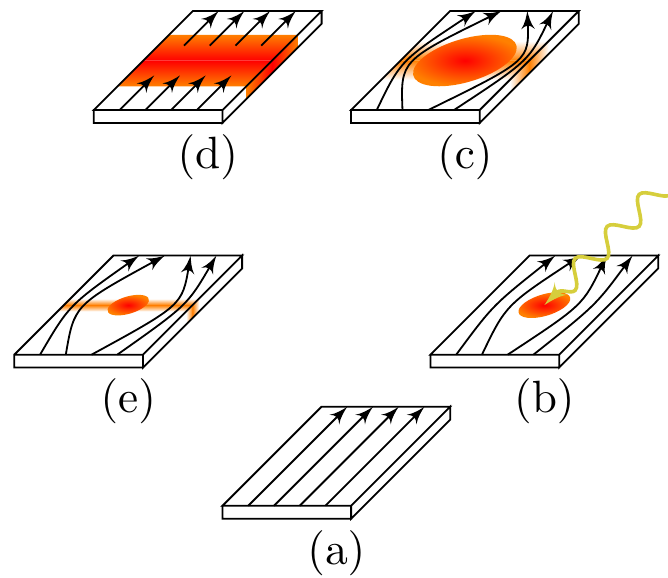
Figure 1. Schematic of the detection process through the hot spot formation after a photon absorption. Equilibrium superconductor is in white, orange to red depicts regions with increasingly suppressed order parameter and black lines depict the superconducting current density. Yellow arrow is a schematic depiction of an incoming single